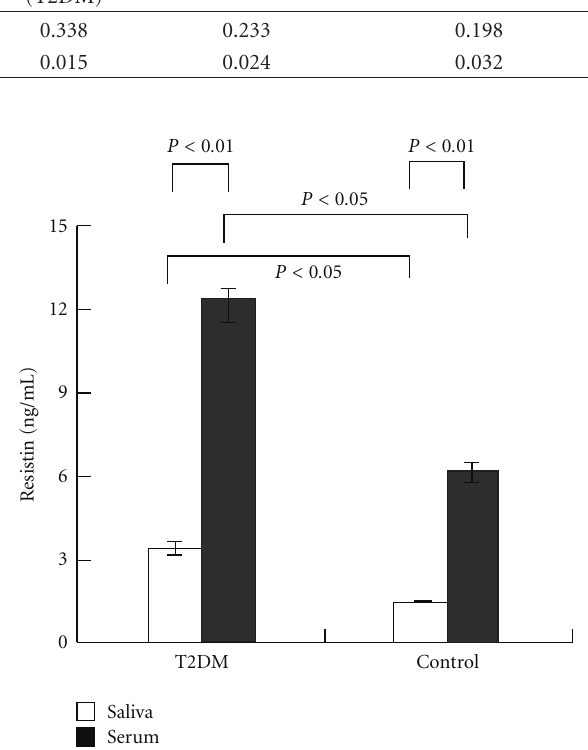
Figure 1: Fasting serum and salivary resistin levels in patients with T2DM and the